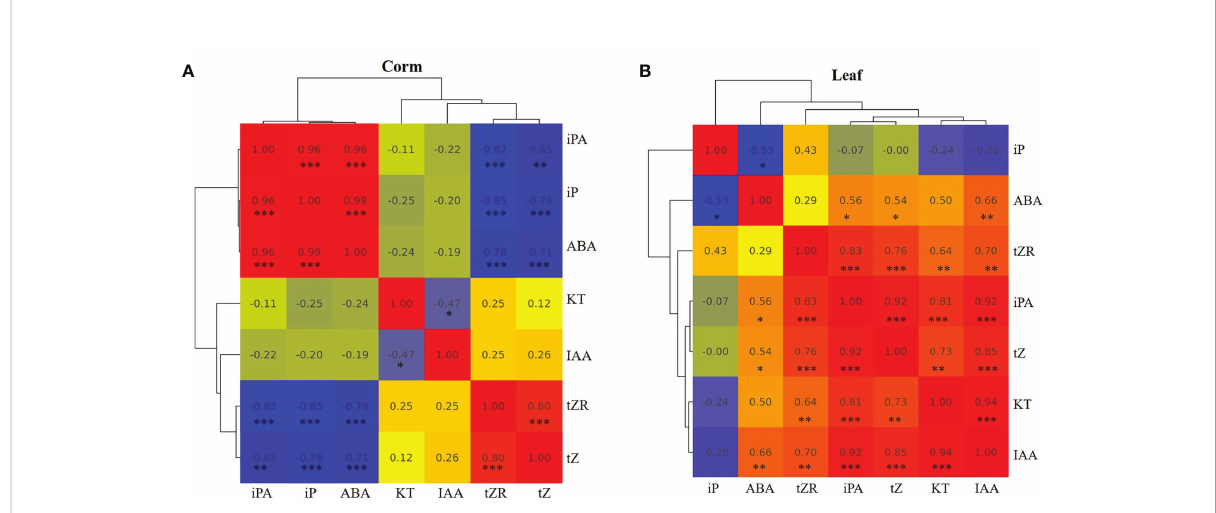
FIGURE 6 Pearson correlation analysis among the hormones in corms (A) and leaves (B) of A. muelleri . Red indicates a positive correlation, and blue indicates a negative correlation. The numbers represent the correlation coef fi cients. Asterisks denote signi fi cant levels, *: P < 0.05; **: P < 0.01; ***: P <